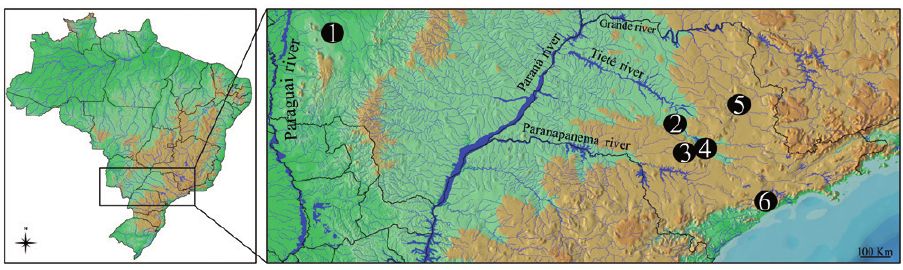
Figure 1. Map of Brazil showing the collection sites of species and populations of Gymnotus analyzed.